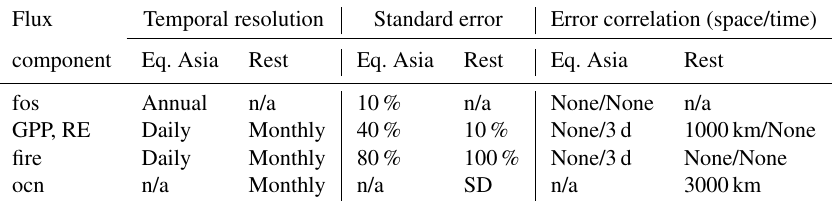
Table 1. Temporal resolution, standard error and error correlation of each flux component, which were separately configured for Equatorial Asia and the rest of the world. Note that the ocean flux was optimised by its absolute value and the others by their scaling factors; therefore, the monthly standard deviation (SD) of the long-term data was used for the ocean flux error and ratios were used for the other flux errors. n/a means not applicable.